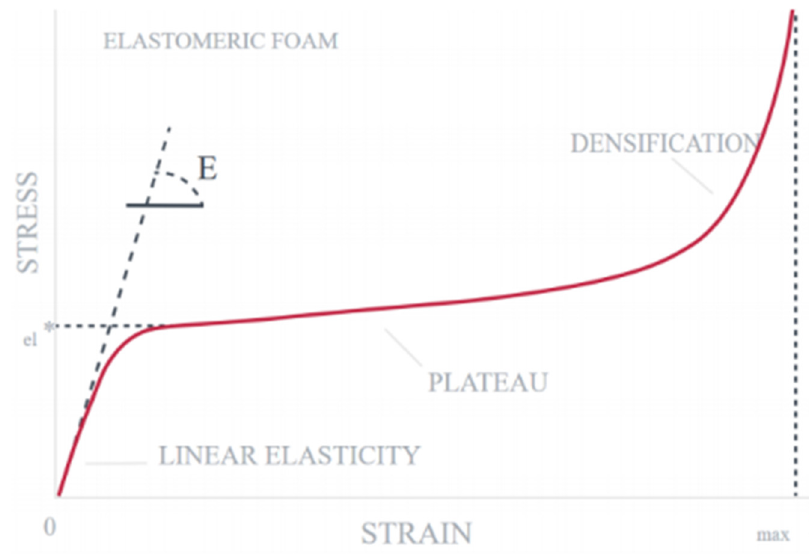
Figure 26. Stress vs. Strain Curve of an elastomeric foam (Carbon (R),